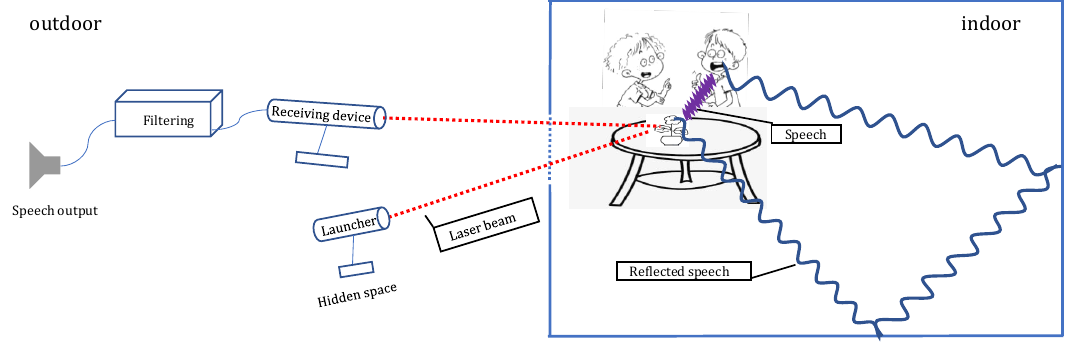
Figure 1. Echo generation in laser monitoring